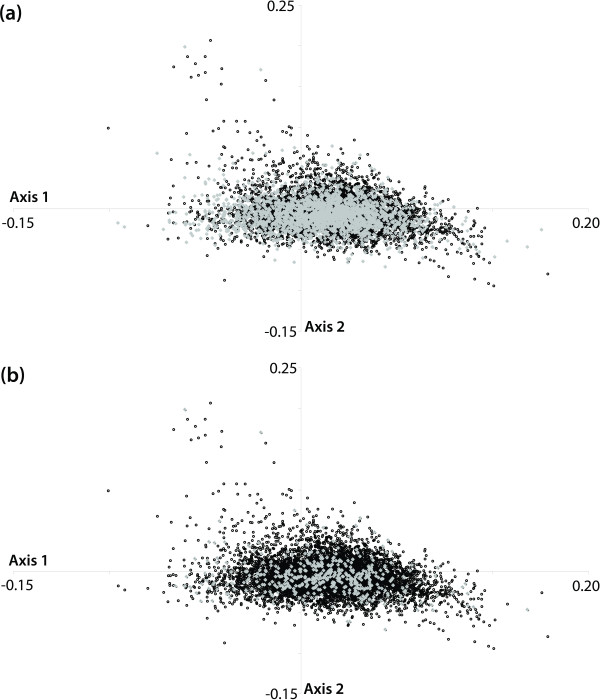
Synonymous codon usage distribution in A. thalianain comparison with codon volatility and highly expressed gene data. The two major axes are shown here, Axis 1 and Axis 2. The darker points on the plots represent the codon usage values for each of the 18,828 genes. (a) The lighter points overlayed on the codon usage distribution are those genes with significant codon volatility P- values (2,181). (b) The lighter points overlayed are those genes that are highly expressed.